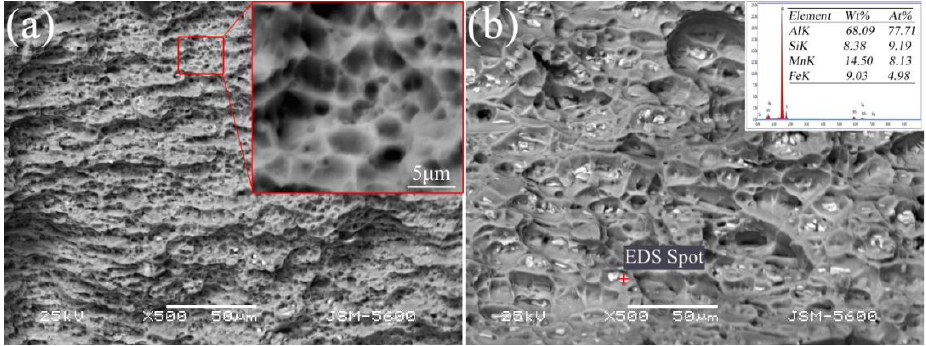
Figure 13. Typical facture surfaces of joints at different rotation speeds: ( a ) 600 r/min, ( b ) 800